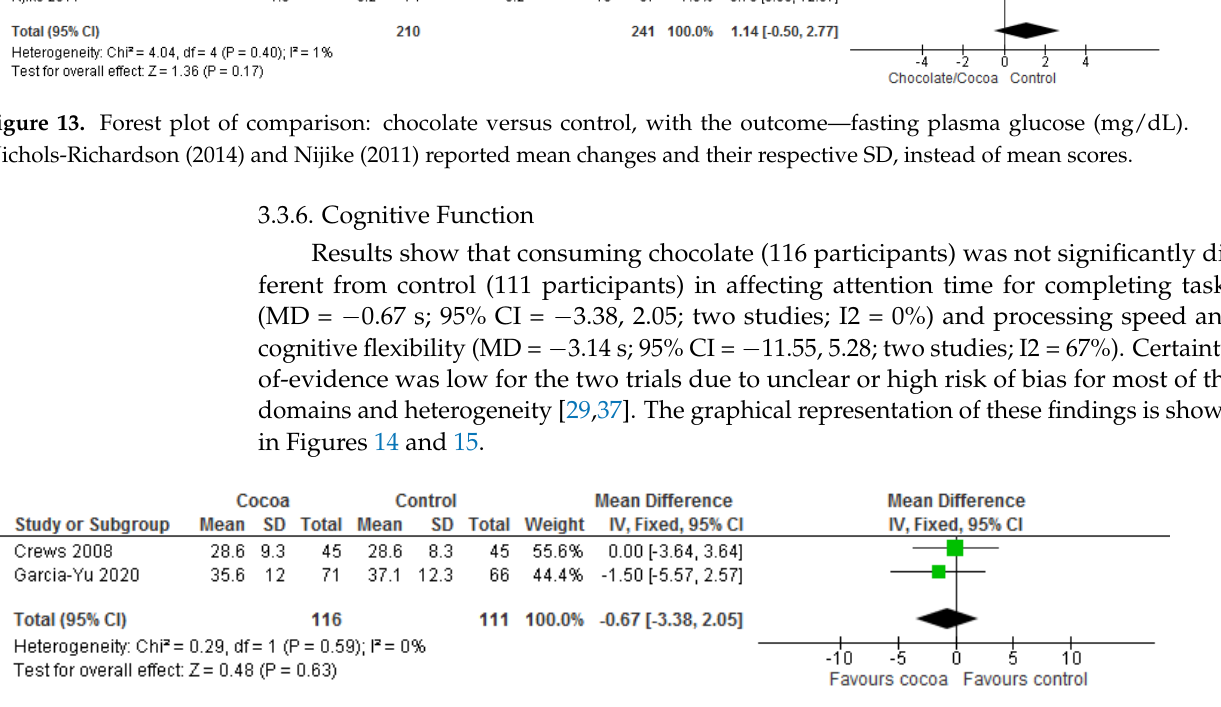
Figure 14. Forest plot of comparison: chocolate versus control, with the outcome-trail marking test (attention) (seconds).